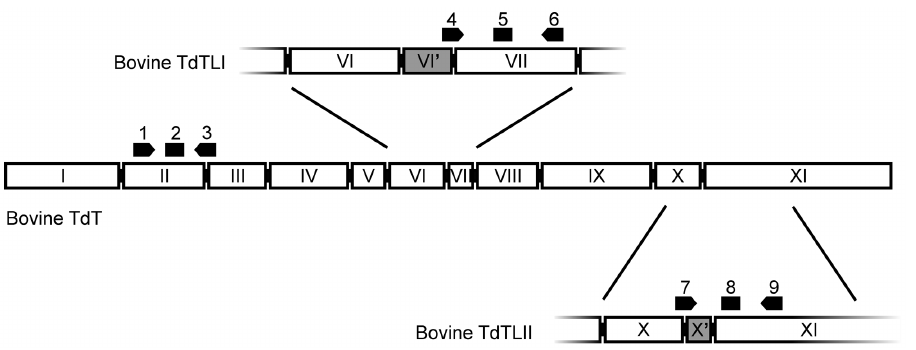
Figure 1. qPCR primers and probes for bovine TdT splice variants. Numbering of exons according to human TdT [68]. Extra exons in the splice variants (VI’ and X’) are numbered according to [20]. Black arrows indicate the primers and rectangles the probes for qPCR, as specified in Table 1. 1. TdT-FW, 2. TdT probe, 3. TdT-REV, 4. TdT_tr2_131_FW, 5. TdT_tr2_131_PR, 6. TdT_tr2_131_RV, 7. TdT_tr1_1925_FW, 8. TdT_tr1_1925_PR, 9. TdT_tr1_1925_RV.